Question: Summarize what this figure shows in one sentence.
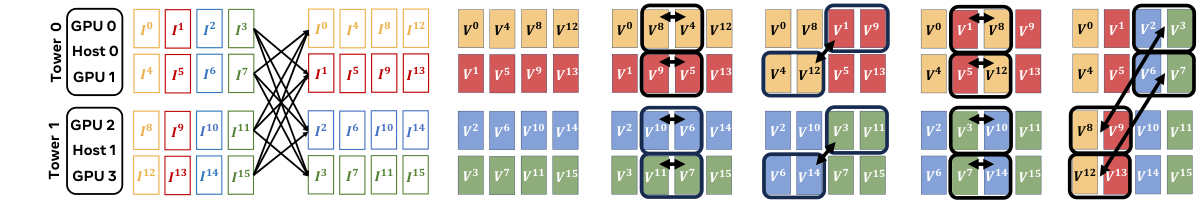
Answer: An operational view of the topology-aware embedding lookup process using semantic-preserving tower transform.